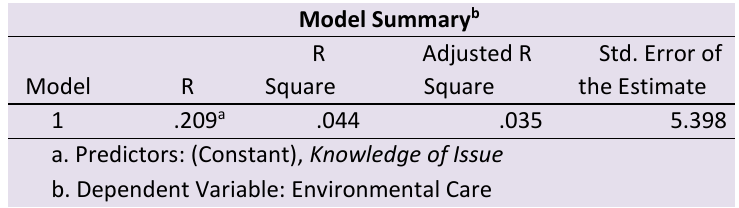
Table 5. Simple Regression Test Results X₁ and Y